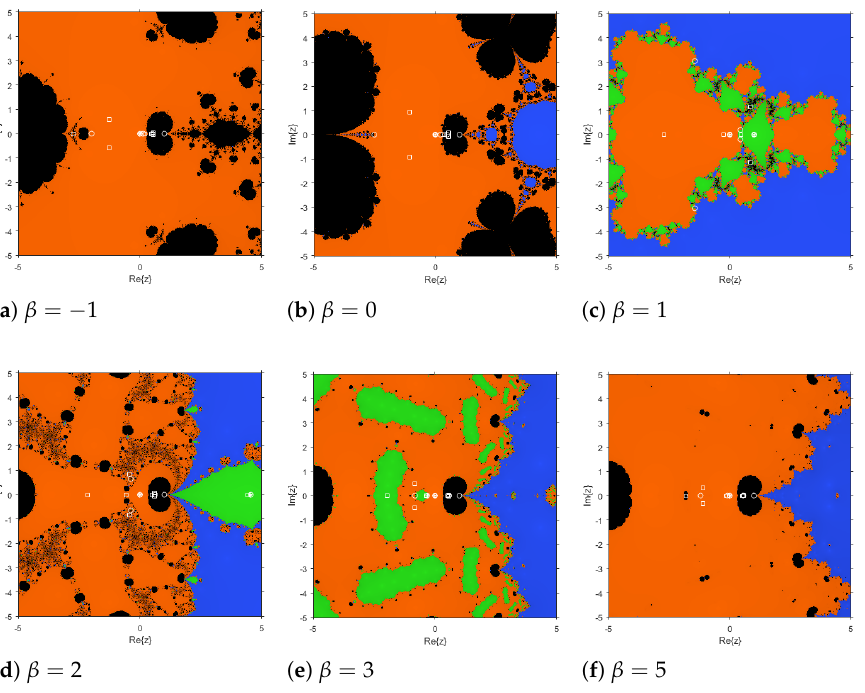
Figure 2. Dynamical planes corresponding to MH ( z , β )